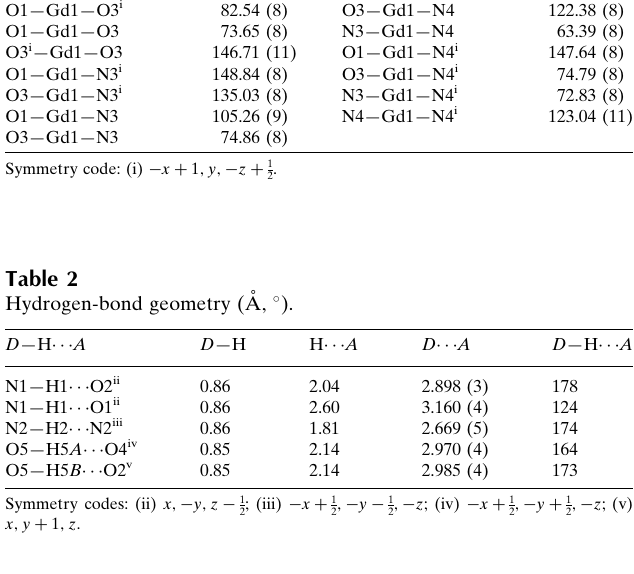
Symmetry codes: (ii) x ; (cid:2) y ; z (cid:2) 1 2 ; (iii) (cid:2) x þ 1 2 ; (cid:2) y (cid:2) 1 2 ; (cid:2) z ; (iv) (cid:2) x þ 1 2 ; (cid:2) y þ 1 2 ; (cid:2) z ; (v) x ; y þ 1 ; z